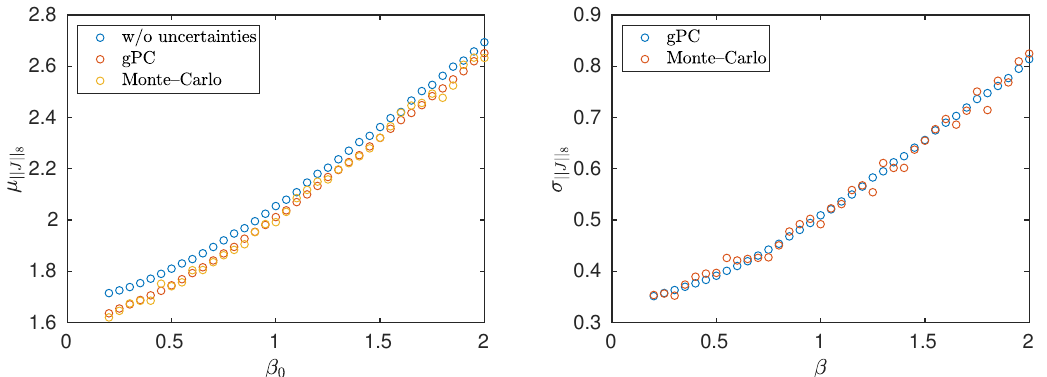
Figure 11. Comparison of mean value (left) and standard deviation (right) of Equation (35), as computed by the gPC coupled with MSS and the Monte–Carlo for N = 7500 samples. In both cases, T = 100. The chaos order is c = 4.